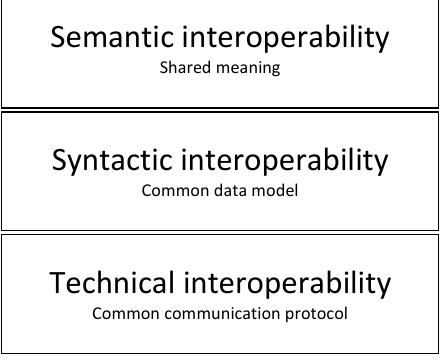
Figure 3. Layers of